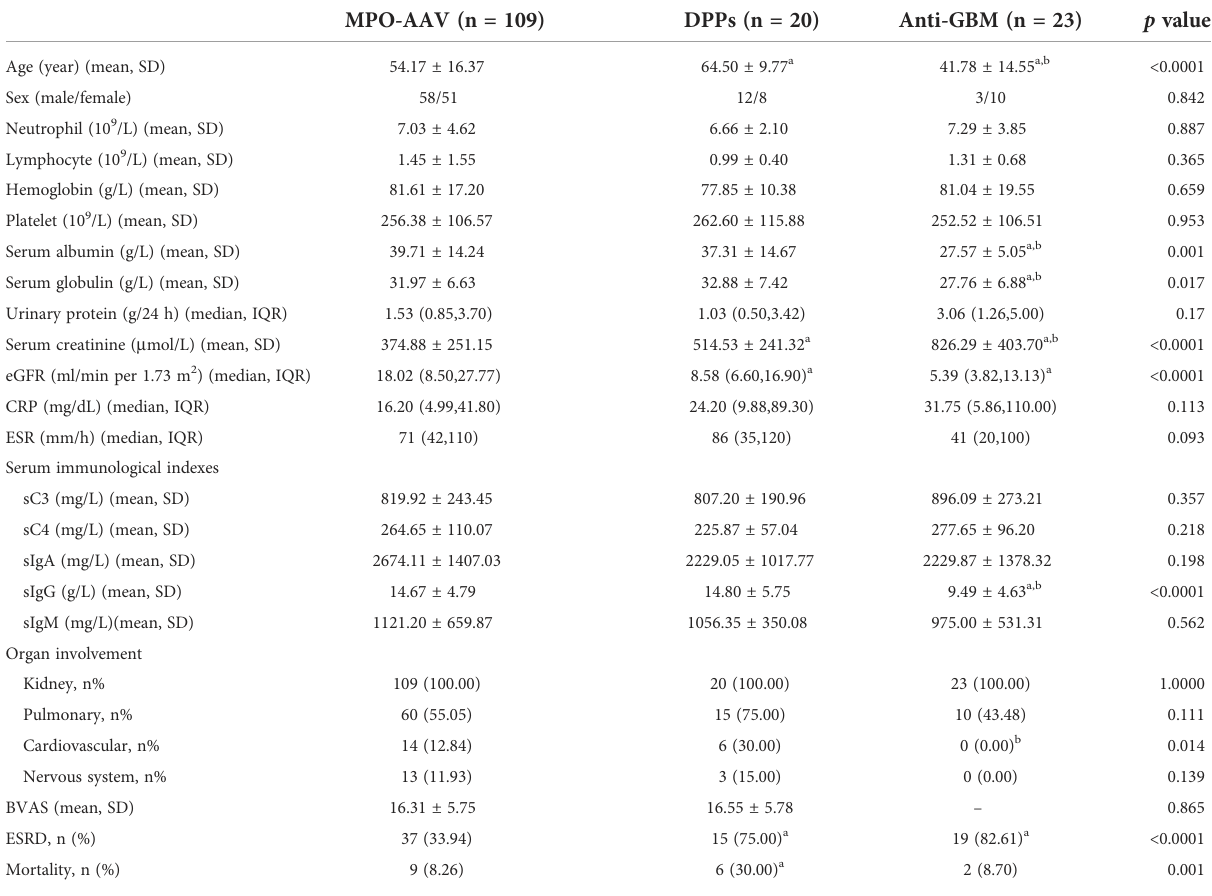
TABLE 1 Baseline clinical